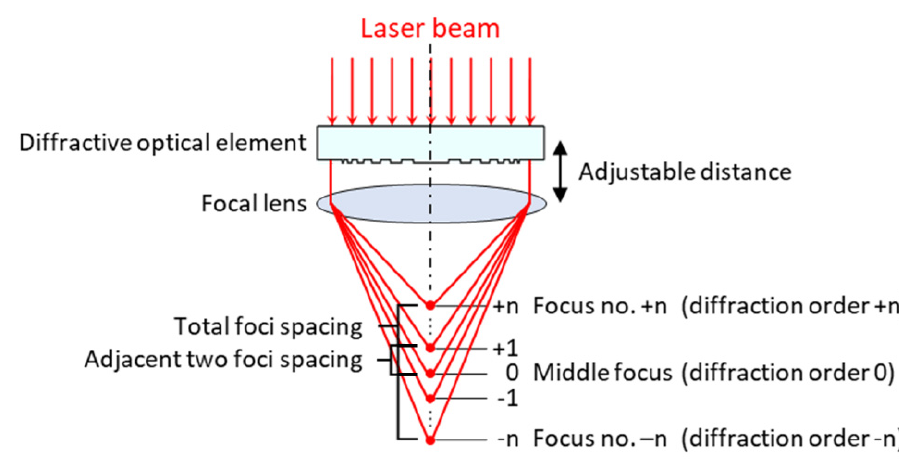
Figure 1. Schematic illustration of generation of multiple foci with a combination of optical diffrac- tive element and focal